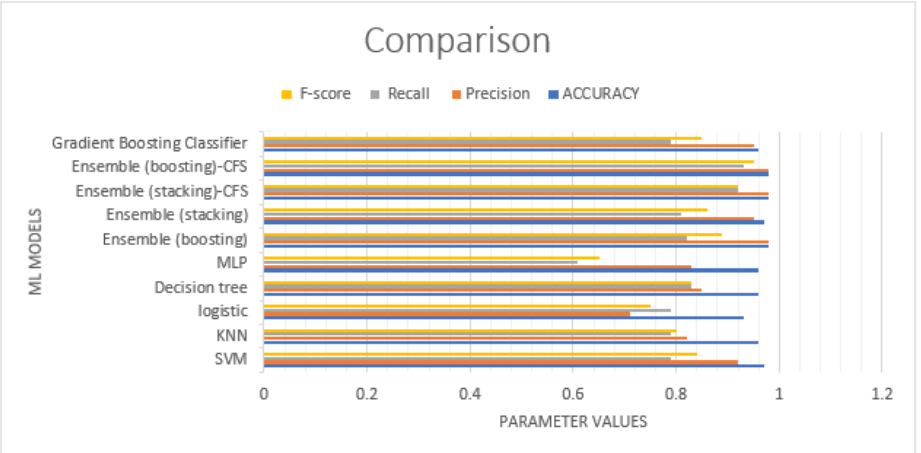
Figure 3. Comparison of proposed and existing approaches on Different Performance Metrics.